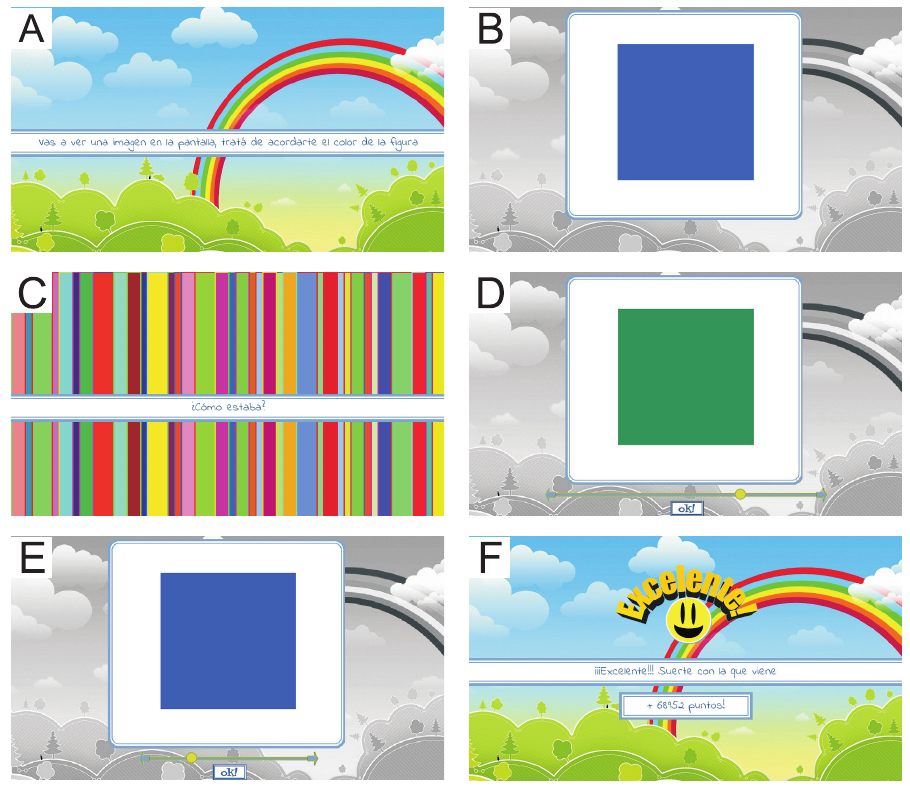
Fig 1. Organization of each memory test. A: Explanatory screen where the player is instructed to remember the color shown next. B: Target color to be remembered. C: Mask containing the instruction to recover the target color in the screen shown next. D and E: Searching screens, where the player continuously changes the color of the central square by displacing the cursor in the bottom bar. The aim is to recover the target color shown before (panel B). The selected color is chosen by clicking on the button labeled “Ok!”. F: Feedback screen, where the expression on the emoticon (that may vary from happy to sad) and the obtained punctuation are determined by the similarity between the target and the responded